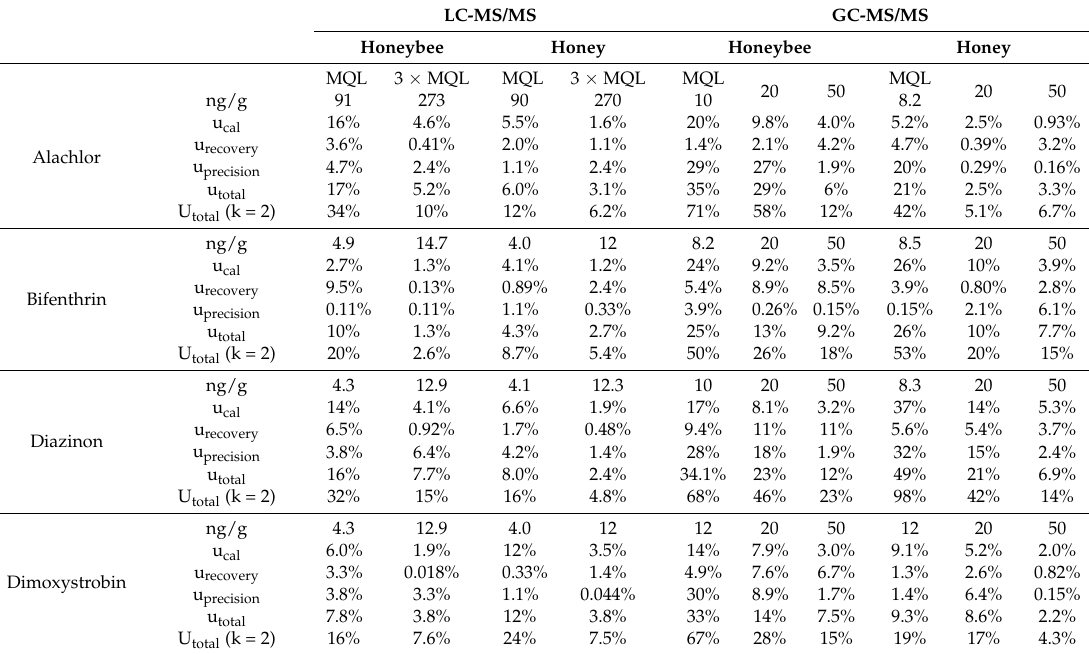
Table 1. Expanded uncertainty for selected pesticides.